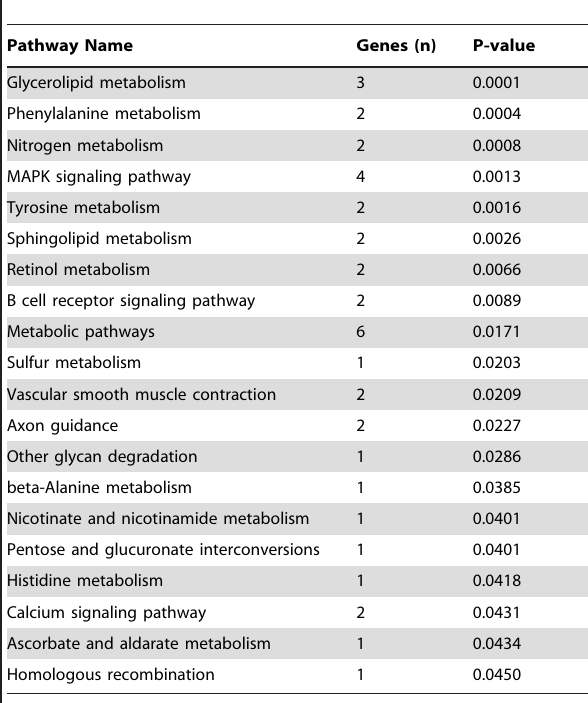
Table 4. Significantly changed pathways in Mu¨ller cells after stretching for 24 h.